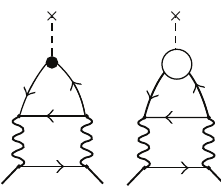
Figure 4: The left one is the AL 1 diagram, and the right one is the AL 2 diagram. The thin and thick lines denote the bare and full Green’s functions,